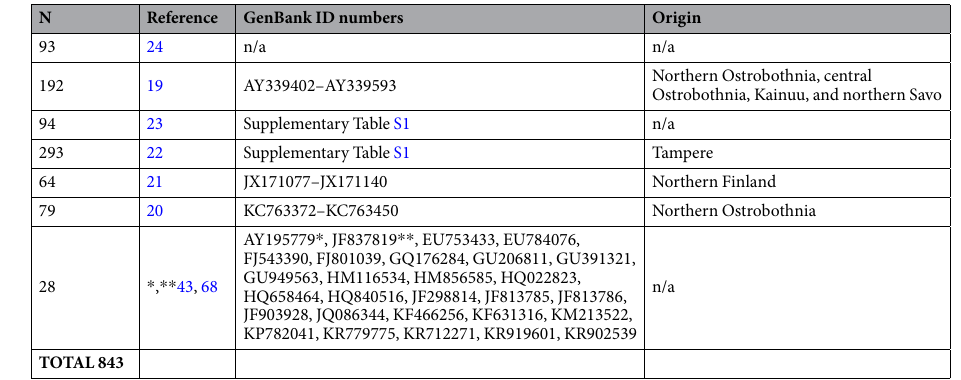
Table 1. Modern human complete mtDNA genomes from Finland (N = 843). Sequences were obtained through GenBank searches, 1000 Genomes data and from previously published